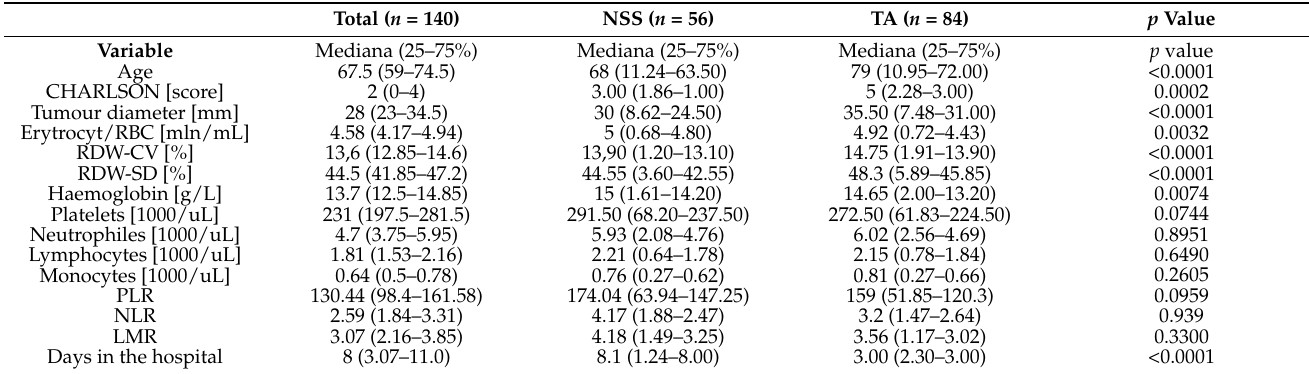
Table 2. Comparison of continuous variables between NSS-treated and TA-treated groups.